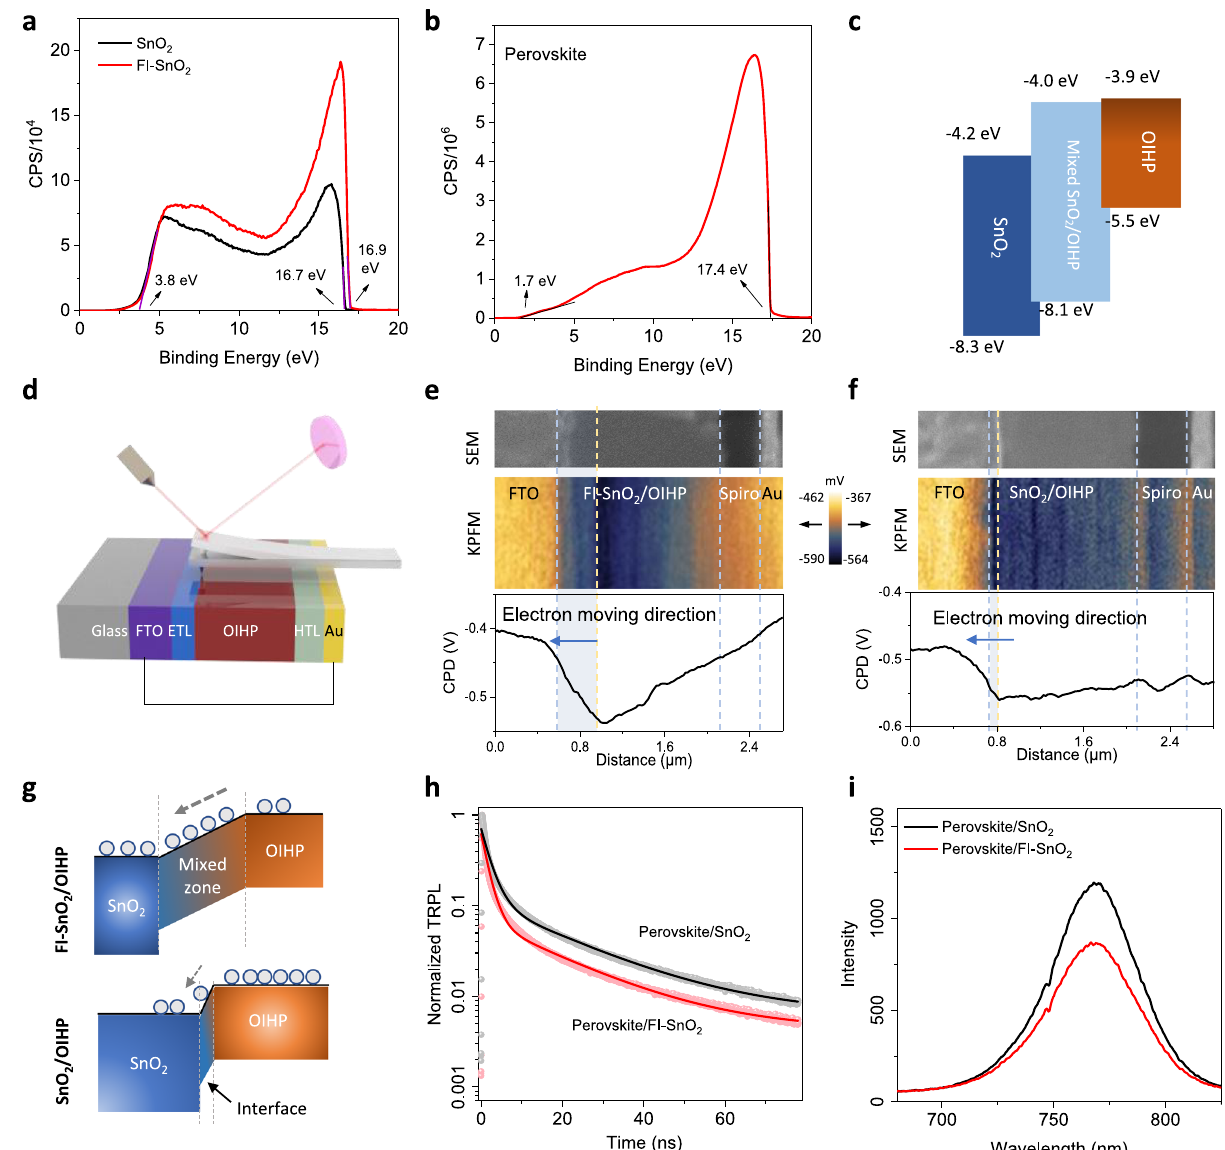
Fig. 3 Electronic properties of SnO 2 – OIHP interfaces. UPS spectra showing the Fermi edge (left) and cutoff energy (right). a FI – SnO 2 and pristine SnO 2 ETLs and b OIHP. c Energy-level diagram across the OIHP/FI-ETL interface. d Schematic illustration of cross-sectional KPFM measurement under short- circuit condition. From top to bottom, SEM image, KPFM image, and contact potential difference (CPD; averaged) pro fi le of the device on, e OIHP/FI – SnO 2 interface and, f pristine OIHP/SnO 2 interface. g Schematic illustration of electron transport characteristics near the OIHP/FI – SnO 2 and pristine OIHP/SnO 2 interfaces, respectively. h TRPL and i steady-state PL spectra of OIHP thin fi lms on FI – SnO 2 and pristine SnO 2